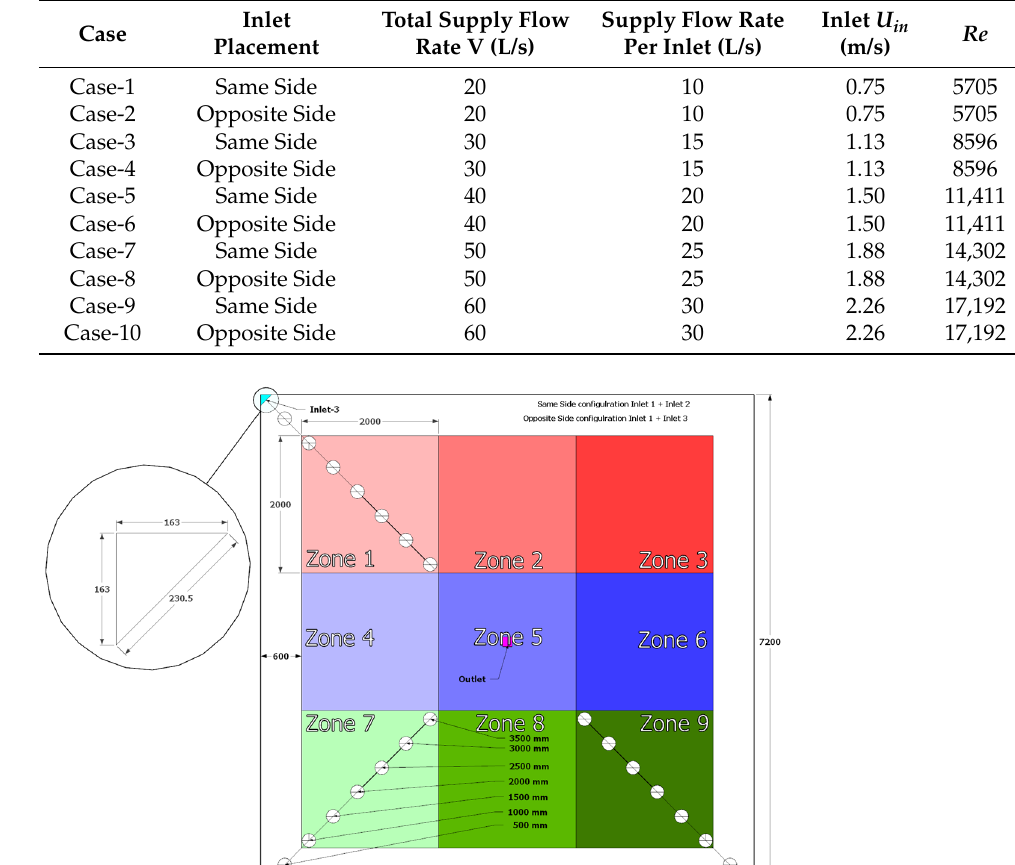
Table 1. Case conditions and parameter settings all cases.